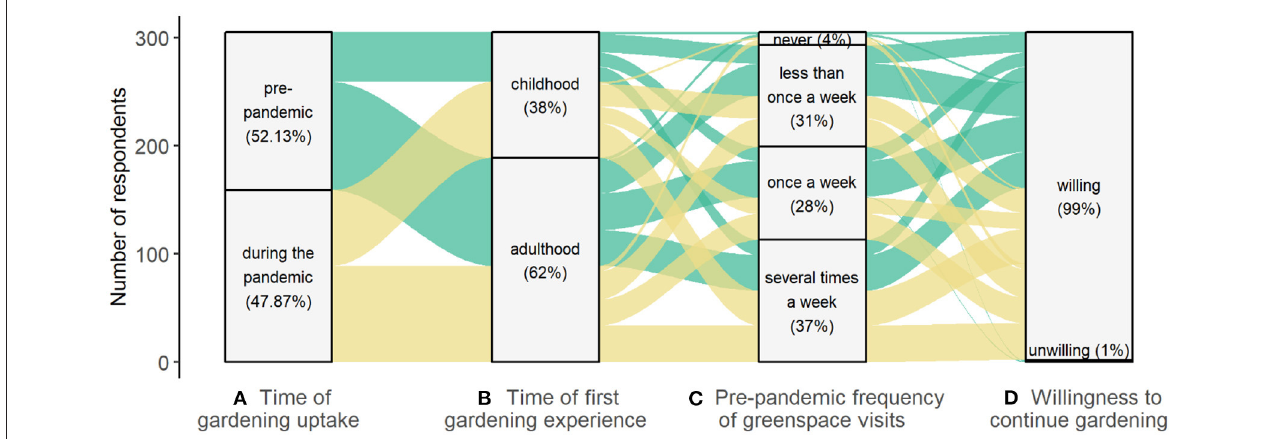
FIGURE 3 | Respondents’ relationship with time of gardening uptake (A) , time of first gardening experience (B) , pre-pandemic frequency of greenspace visits (C) , and (D) willingness to continue gardening after the pandemic. Colored lines indicate the proportion of respondents who took up gardening pre-pandemic (yellow) or during the pandemic (green). There were no significant differences according to the time of gardening uptake in relation to time of first gardening experience or pre-pandemic frequency of greenspace visits; for details see Supplementary Table 3 .